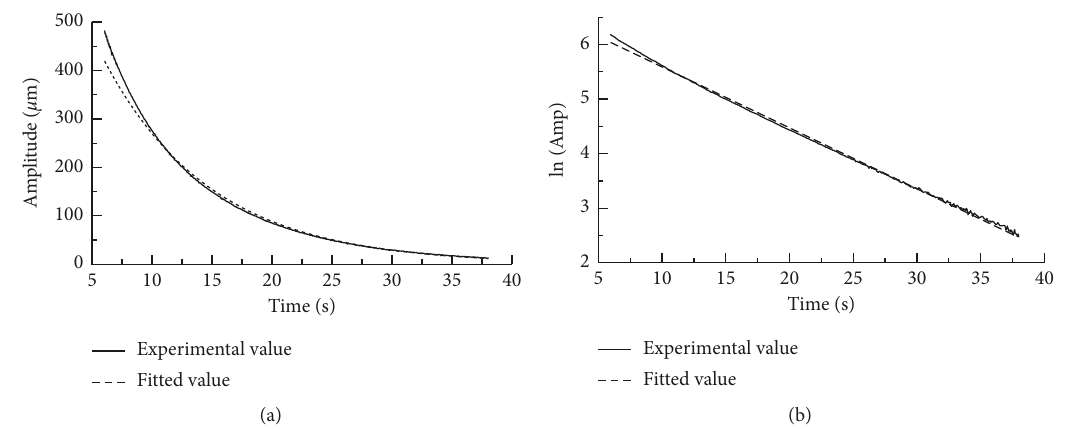
Figure 10: Curve fittings of amplitude for the impact response: (a) power function curve fitting and (b) linear fitting.